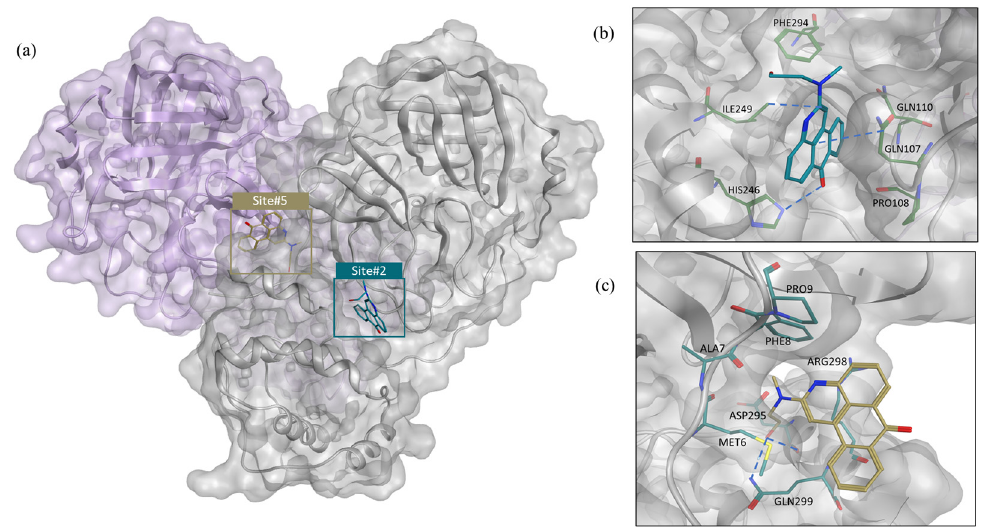
Figure 4. ( a ) The M pro dimer crystal structure showing GR04 as predicted by docking in allosteric sites #2 and #5. ( b ) The predicted binding mode of GR04 in allosteric site #2. ( c ) The predicted binding mode of GR04 in allosteric site #5. For clarity, superimposition on the dimer form of M pro (PDB: 7CAM [34]) was performed to demonstrate binding onto the dimerization site.